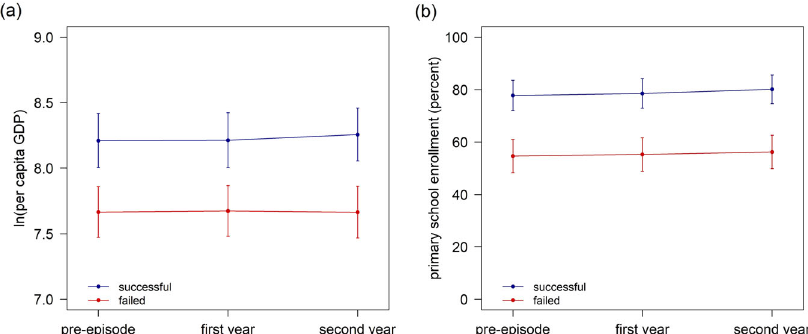
Fig. 3 Initial conditions of GDP and primary school enrollment for successful and failed liberalization episodes. Successful (blue) and failed (red) episodes differed signi fi cantly in the year the episodes began, as well as the years just before and after in ( a ) GDP and ( b ) education (99.9 percent con fi dence intervals).